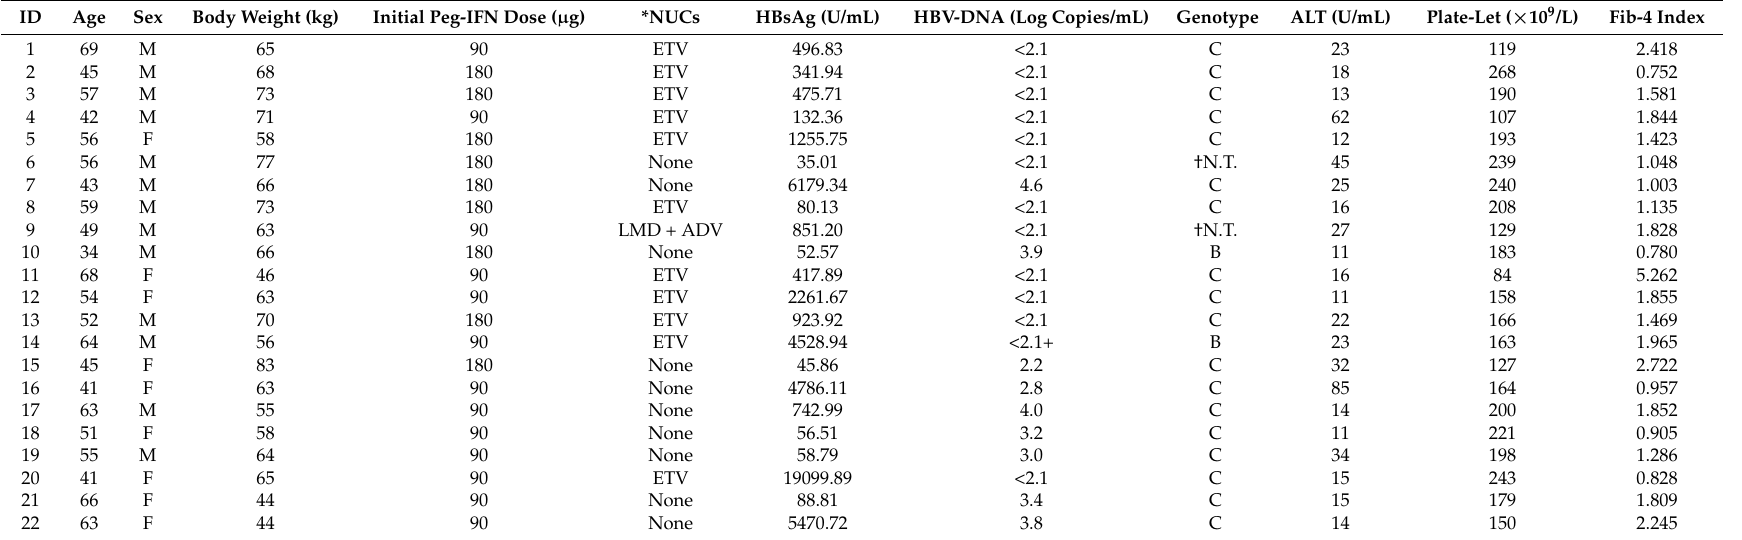
Table 1. Baseline patient